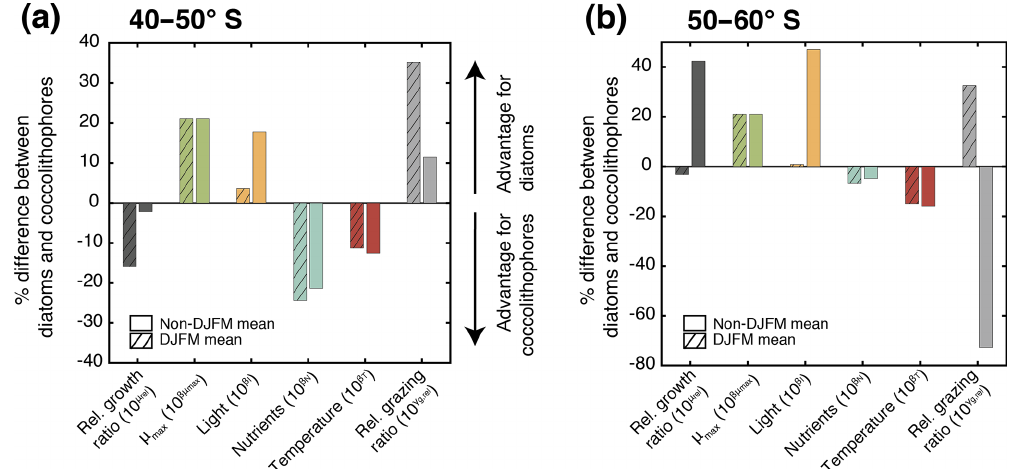
Figure 6. Percent difference in growth rate (dark grey), growth-limiting factors (maximum growth rate µ max in green, nutrient limitation in blue, light limitation in yellow, and temperature sensitivity in red), and grazing rate (light grey) of diatoms and coccolithophores for (a) 40– 50 ◦ S and (b) 50–60 ◦ S. Respective left bar shows the December–March average (DJFM) calculated from the non-log-transformed ratios (e.g., the red bar represents 10 β T ; see Eq. 4), and the shaded right bars show the average for all other months (non-DJFM). Full seasonal cycle is shown in Fig. 5a and b.